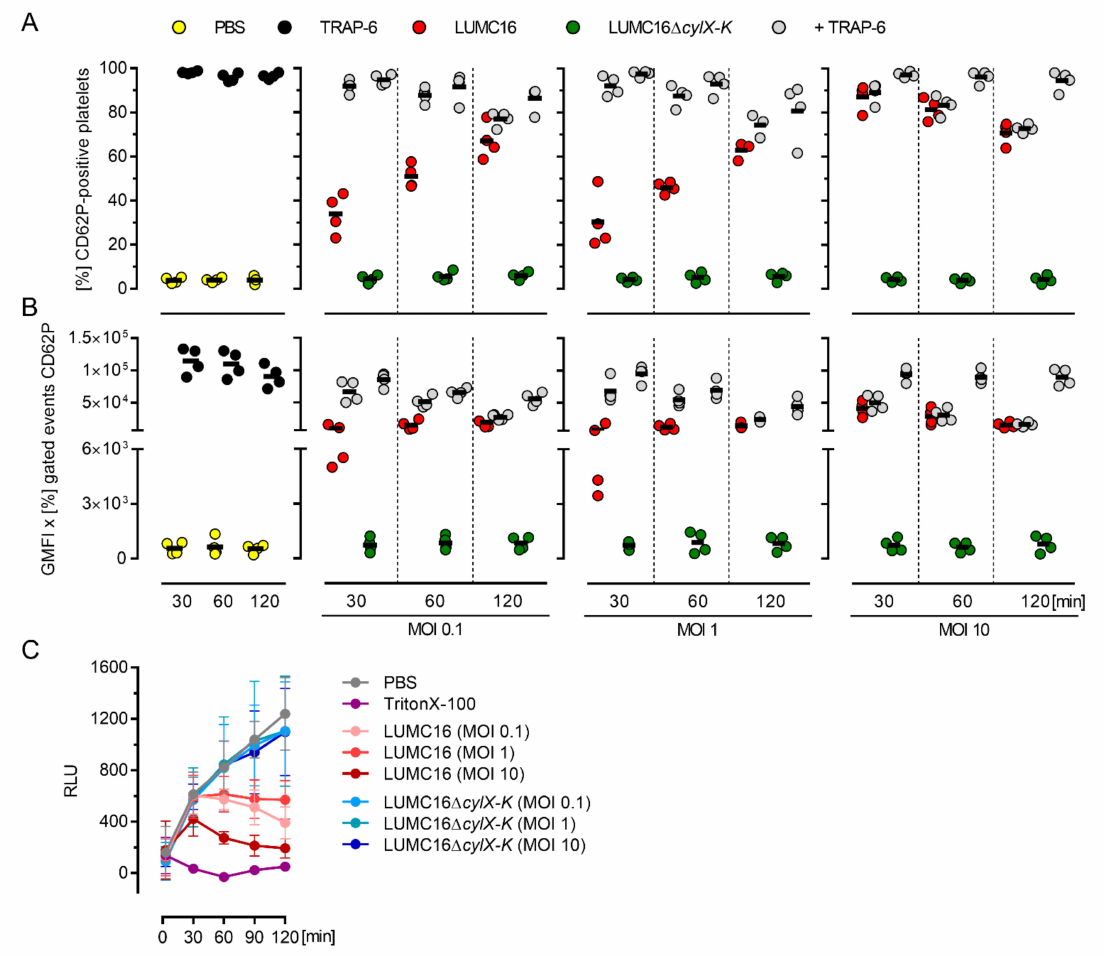
Figure 1. Pigmented GBS activate and kill human platelets. Washed human platelets were infected with the pigmented LUMC16 and the non-pigmented LUMC16 ∆ cylX-K GBS strains at MOI 0.1, MOI 1.0, and MOI 10. (A) Platelet activation was measured via flow cytometry using a PE-Cy5 labelled CD62P antibody. TRAP-6 (40 µ M) and PBS were used as positive and negative controls, respectively. Alternatively, 5 min prior to the end of infection, TRAP-6 (40 µ M) was added. The activation process was evaluated by assessing frequencies of CD62P-positive cells ( A ) as well as expression of CD62P ( B ). Each dot in A and B represents one independent experiment with washed platelets from one donor ( n = 4). Horizontal lines depict mean values. ( C ) Kinetics of platelet viability. PBS and TritonX-100 were used as controls. Each dot represents the mean ± SD from four independent experiments ( n =